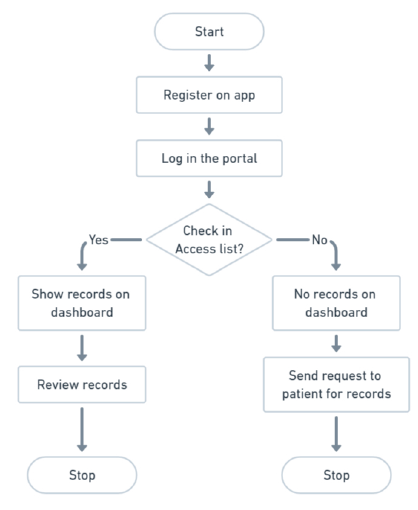
Figure 3. Flow Diagram for doctor